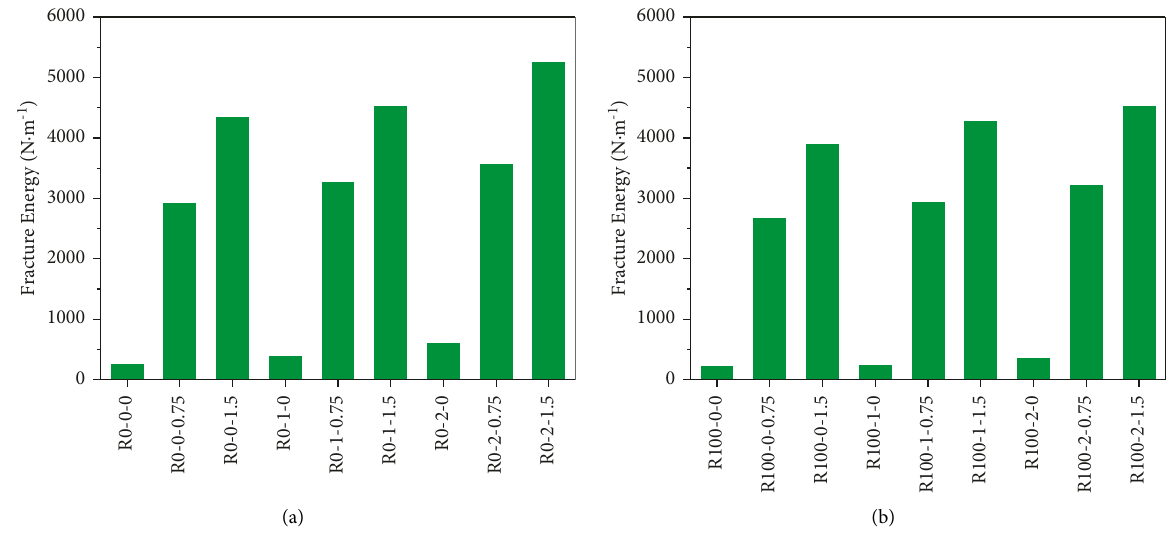
Figure 11: Fracture energy. (a) Replacement rate of 0%. (b) Replacement rate of